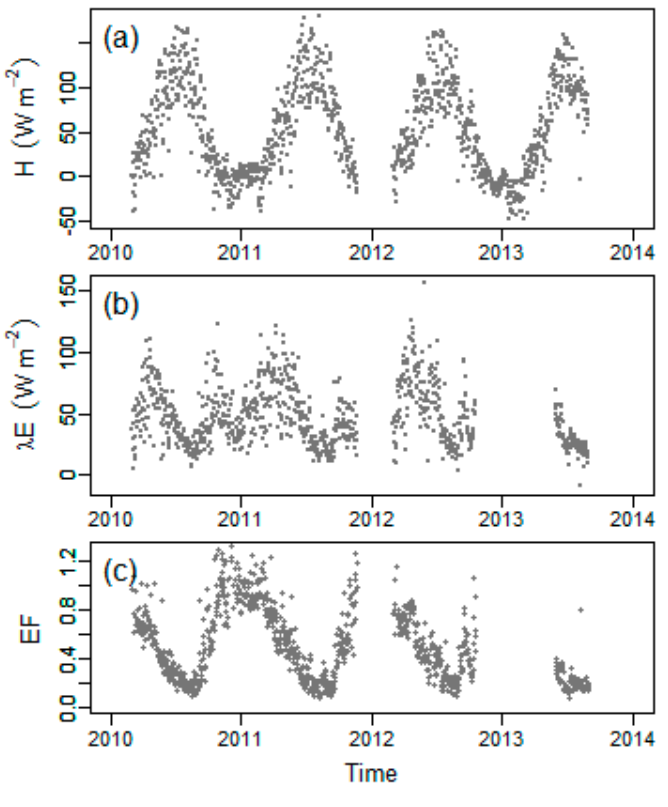
Figure 5. Seasonal evolution of the land surface fluxes at daily time scale. ( a ) Sensible heat flux (H); ( b ) Latent heat fluxes ( λ E); ( c ) Evaporative fraction. Both fluxes were gap-filled by REddyProc, without separating the wind directions